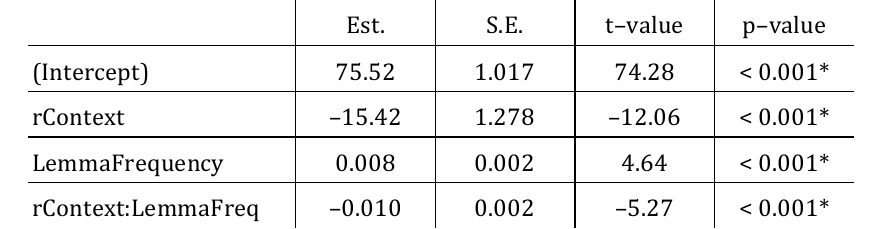
Table 1: Mixed-effects model for Low